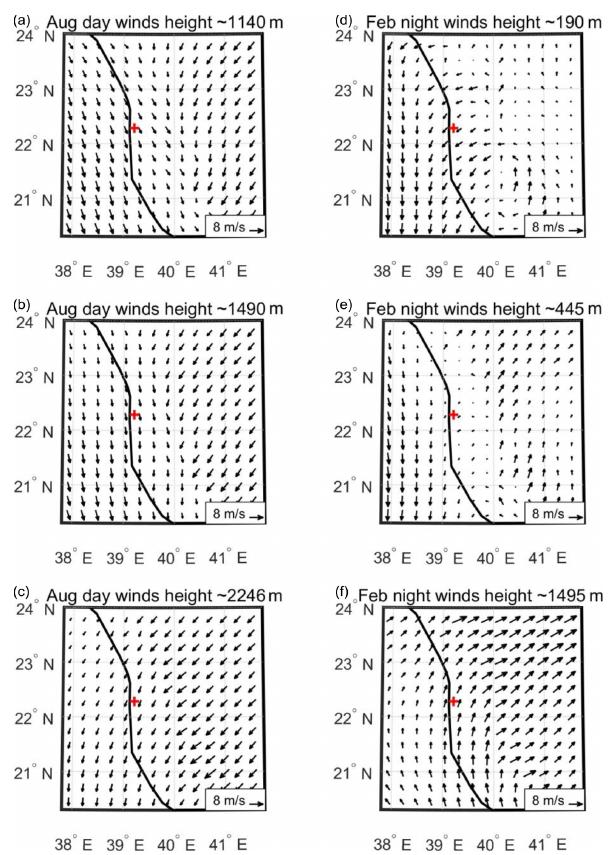
Figure 17. Model (WRF) winds at three different elevations for Au- gust (a–c) and February (d–f) within the study domain. The KAUST site is marked by a red ( + )